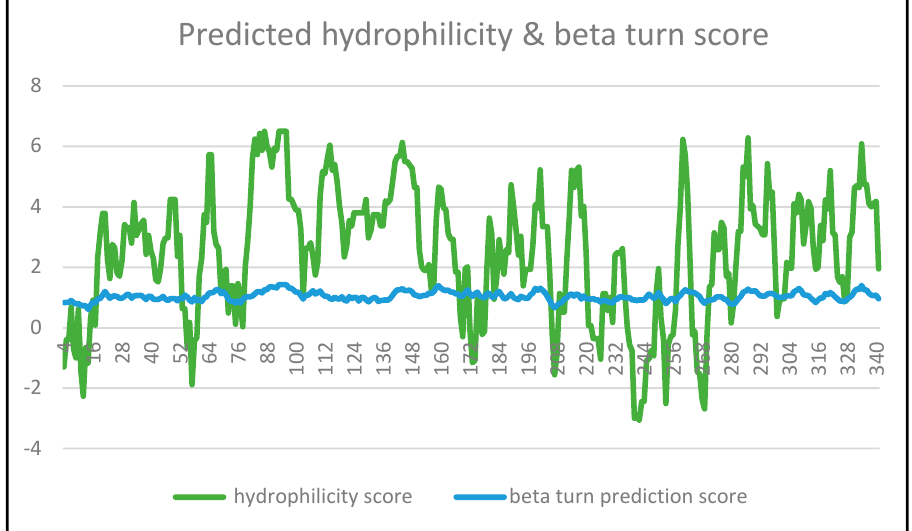
Figure 7. Prediction scores for hydrophilicity and beta-turn of the fungal protein for each amino acid residue. Table 4. Different prediction scores for each amino acid in the first predicted B cell epitope.